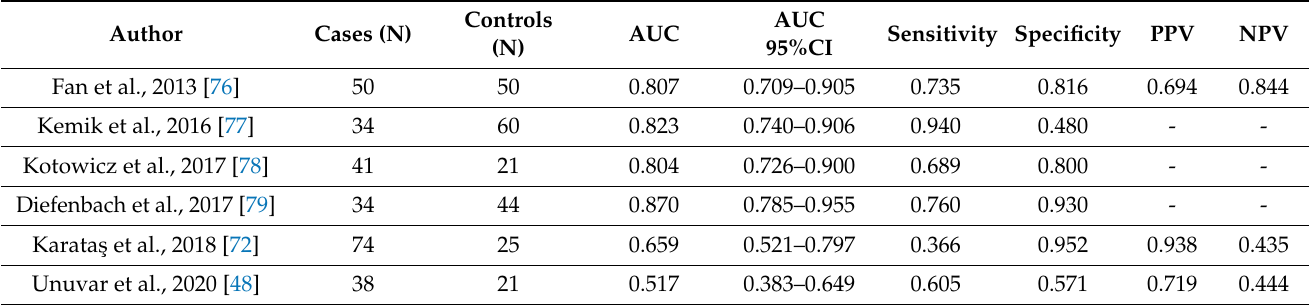
Table 13. Summary table of the performance of